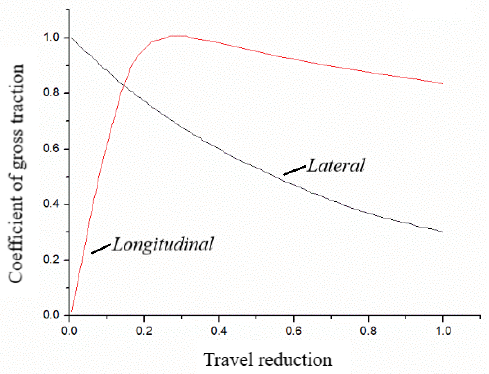
Figure 4. Relationship of travel reduction and coefficient of gross traction.